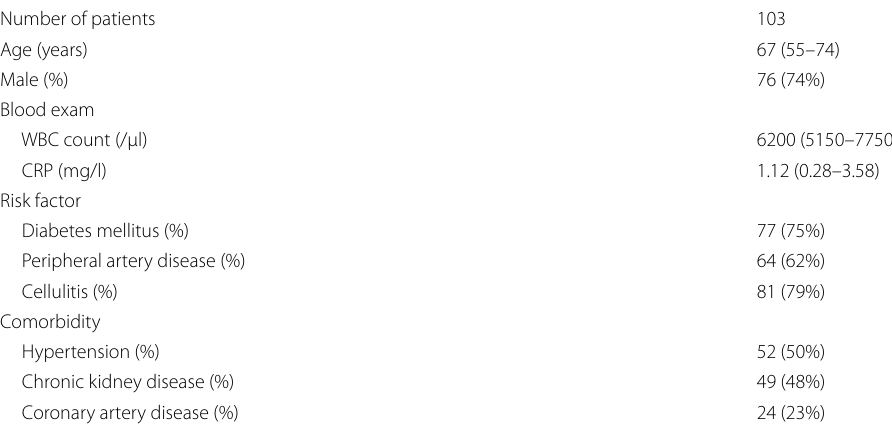
WBC white blood cell; CRP C‑reactive protein